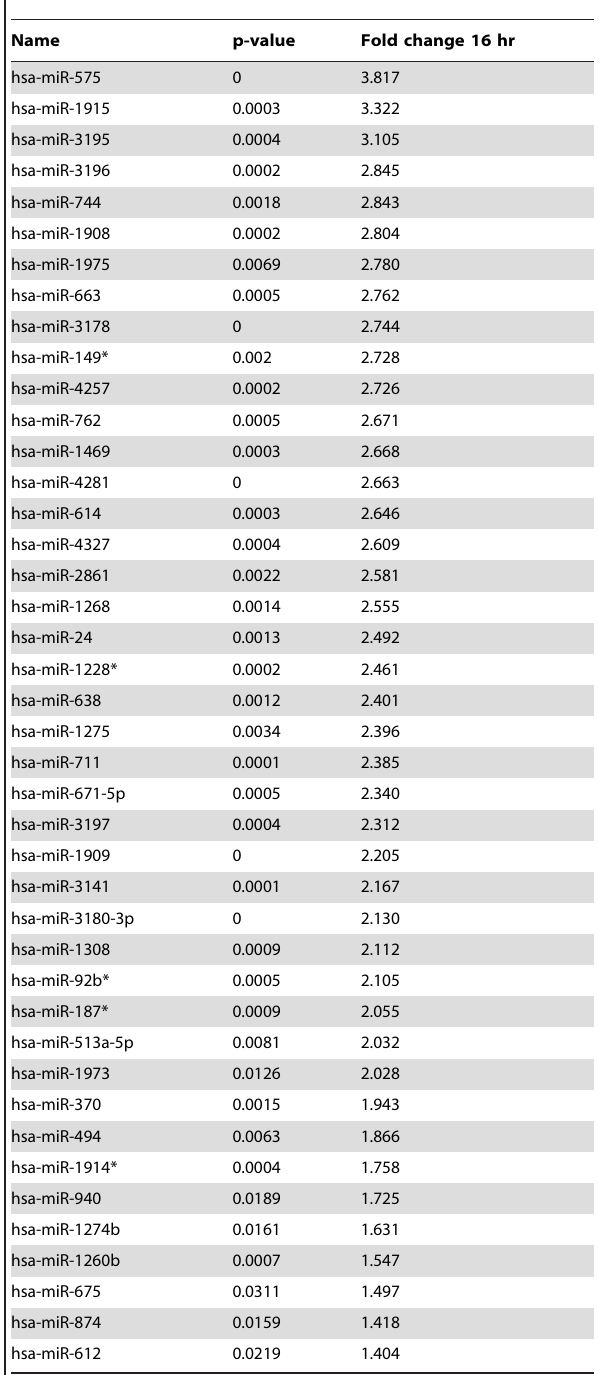
Table 3. Up-regulated miRNA species in H1 hESC at 16 hr post 1 Gy of IR exposures (p , 0.05).